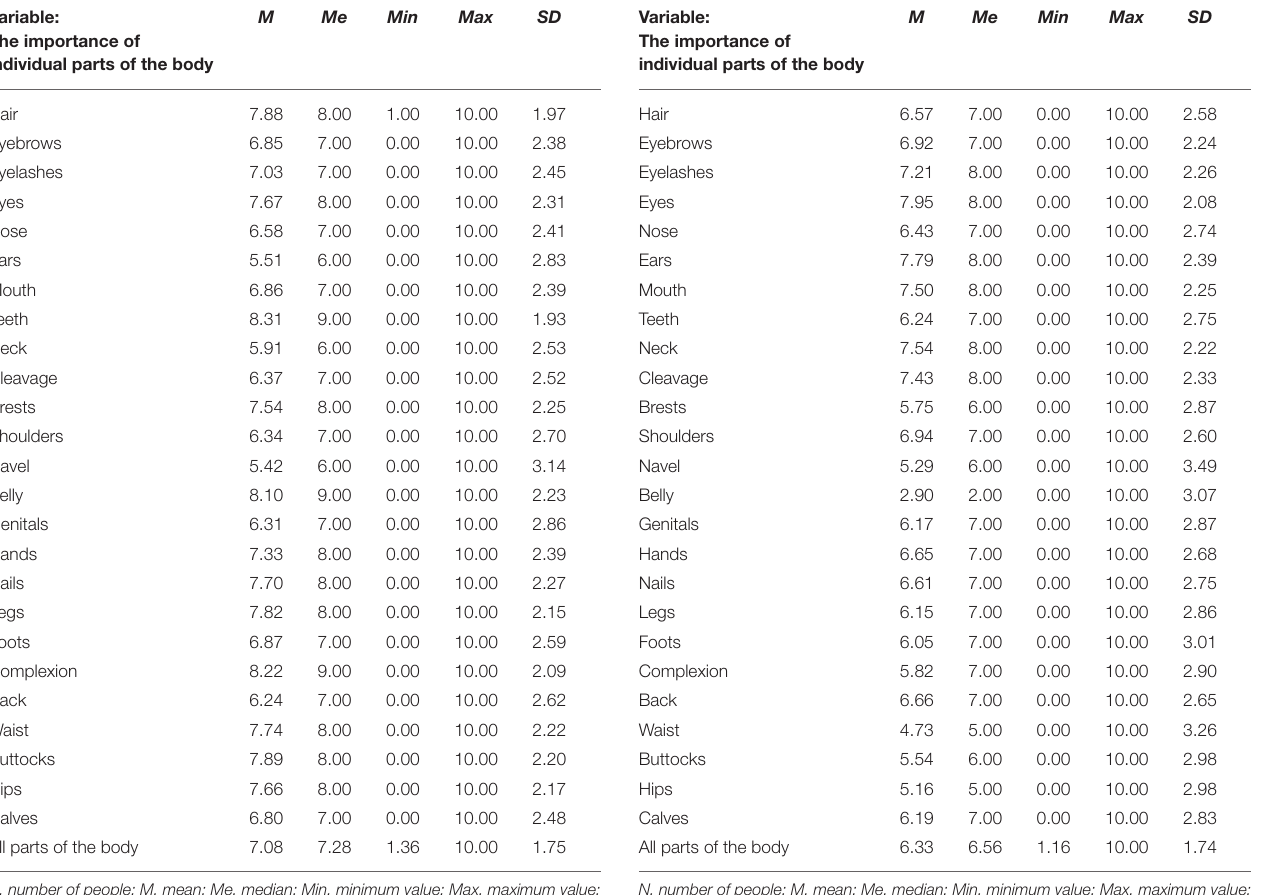
TABLE 8 | Descriptive characteristics of means in terms of the level of satisfaction, i.e., satisfaction with the appearance of individual parts of the body in women diagnosed with DRAM ( N =